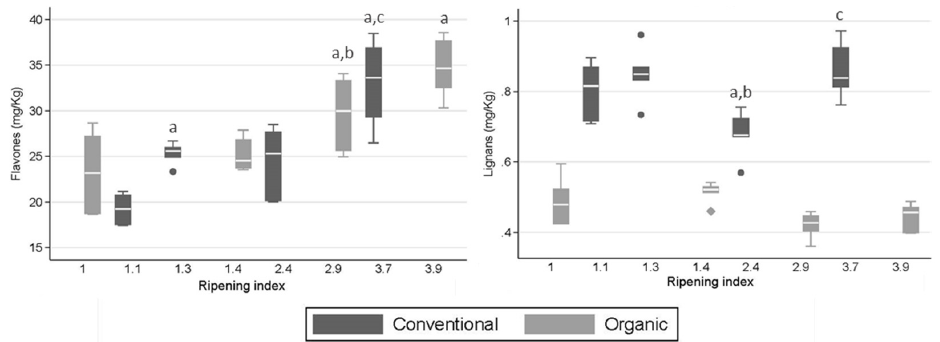
Figure 1. Boxplots for concentrations (mg · kg − 1 ) of total phenols (TP) and polyphenolic groups in extra-virgin olive oil (EVOO) by ripening index (RI) and growing method. (a means p < 0.05 vs. 1st RI, b means p < 0.05 vs. 2nd RI, c means p < 0,05 vs. 3rd RI within the same growing. Table 1. Phenolic compound contents (mg · kg − 1 ) of conventional and organic EVOO made from Hojiblanca olives. * p -values of U Mann–Whitney test. Organic